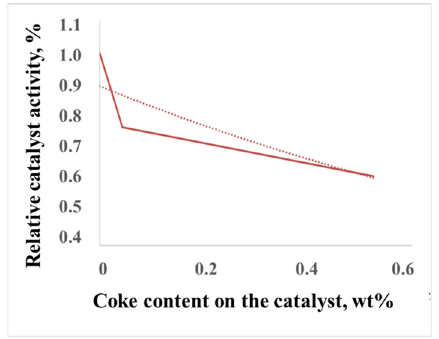
Figure 6. Dependence of relative catalyst activity on the coke content on the